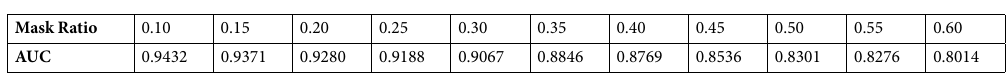
Figure 1. Performance evaluation of ILRMR in two situations based on LOOCV. (1) ILRMR with all information (ILRMR); (2) ILRMR without weight matrix W .